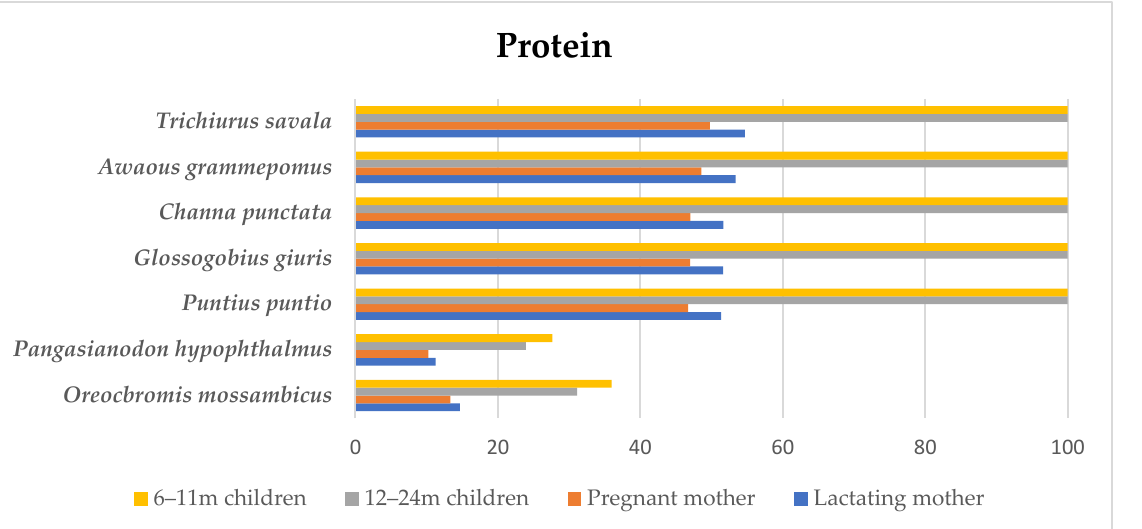
Figure 2. Potential contribution (%) of dry fish to the recommended nutrient intake (RNI) of protein for children and pregnant and lactating women in Bangladesh. Local names: Churi ( Trichiurus savala ), Bele ( Awaous grammepomus ), Taki ( Channa punctata ), Bele ( Glossogobius giuris ), Punti ( Puntius puntio ), Thai Pangas ( Pangasianodon hypophthalmus ), and Tilapia ( Oreocbromis mossambicus ).